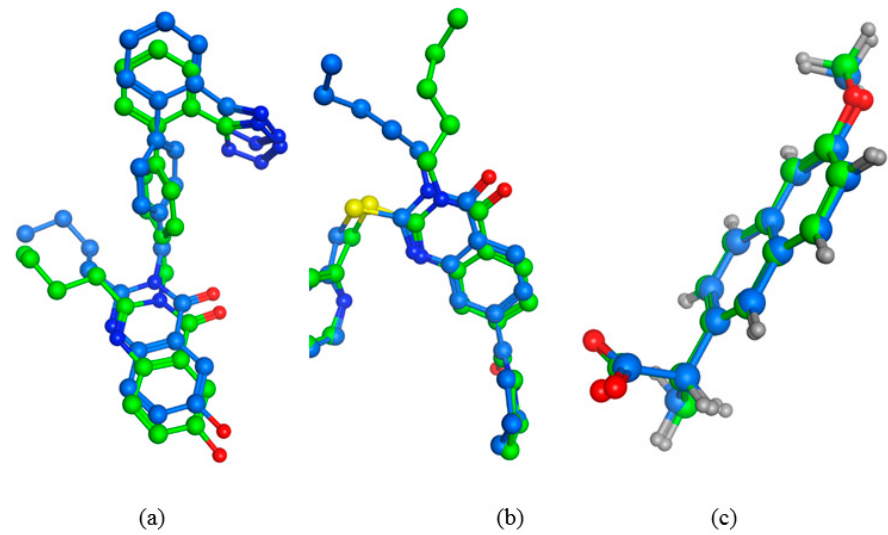
Figure 5. Comparison of X-ray determined structure with docking pose of native ligand ( a ) for B. fragilis : PDB 1A8T (blue: X-ray pose, green; docking pose for 061 ); ( b ) for E. coli : PDB 4XVE (green: X-ray pose, blue: docking pose for WDS ); ( c ) for COX-2: PDB 3NT1 (blue: X-ray pose, green: dock pose for NPS ).